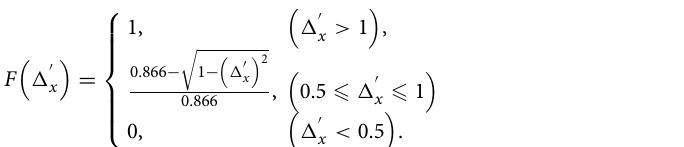
8 can be defined as: x in sandy silt